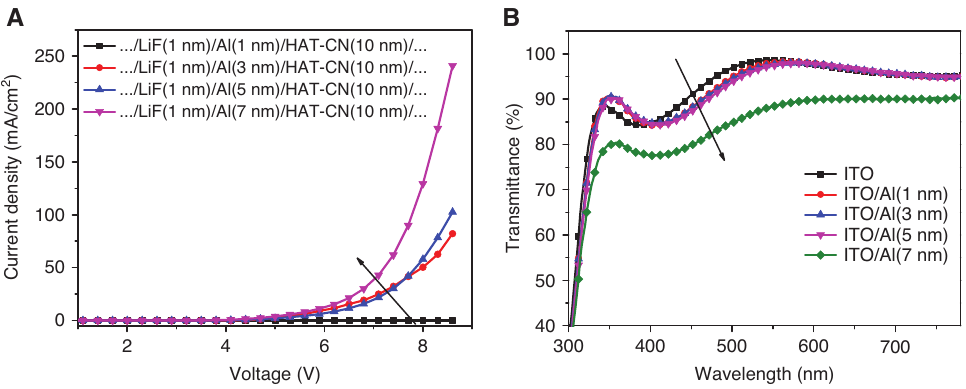
Figure 3: (A) The J–V curves of carrier-only devices based the CGU with different Al film thickness of 1, 3, 5, and 7 nm; (B) the transmittance curves of ITO(180 nm) and ITO(180 nm)/Al(1, 3, 5, and 7nm)